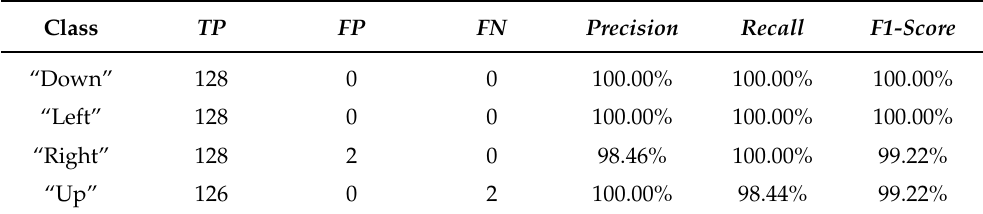
Table 7. Performance metrics of the network trained and validated with data in Figure 6d.